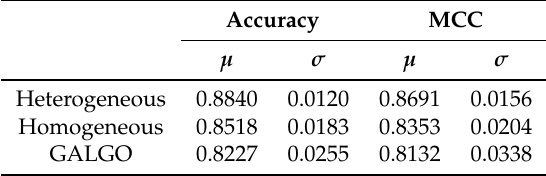
Figure 8. Nine recurrent features in the 5-feature signature for the GALGO. Table 5. µ and σ for accuracy and MCC over 10 runs using the top 5 features, for each